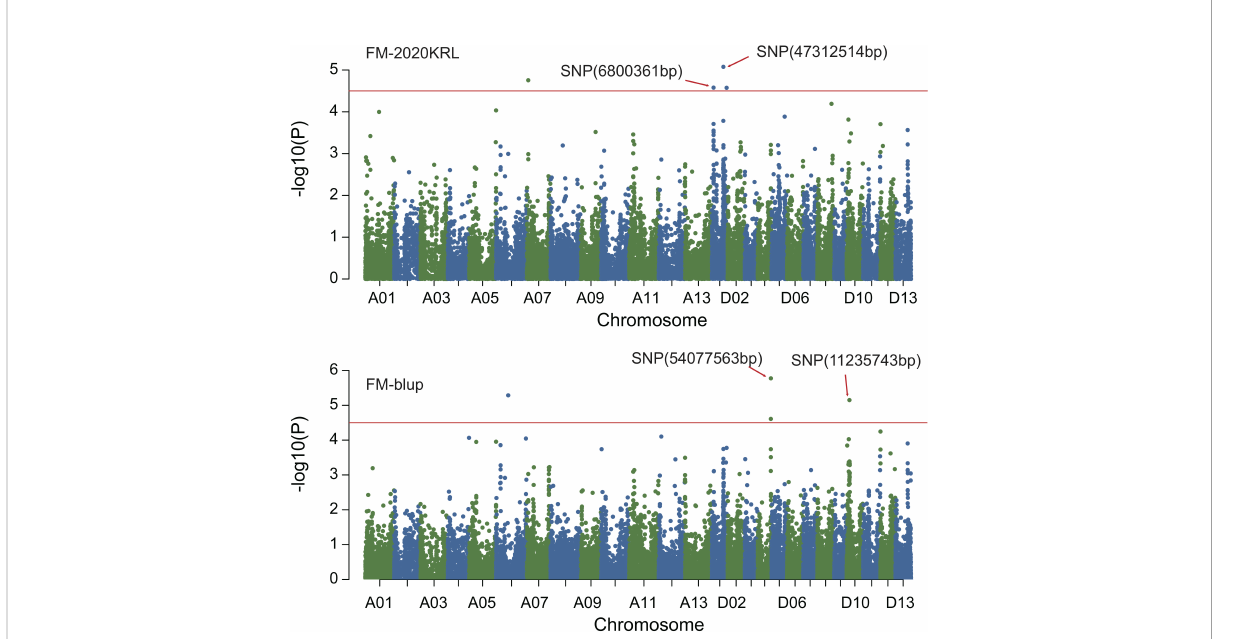
FIGURE 5 Manhattan of genome-wide association studies for micronaire. FM-2020KRL: Micronaire in the Korla environment in 2020; FM-blup: Micronaire in the blup environment in